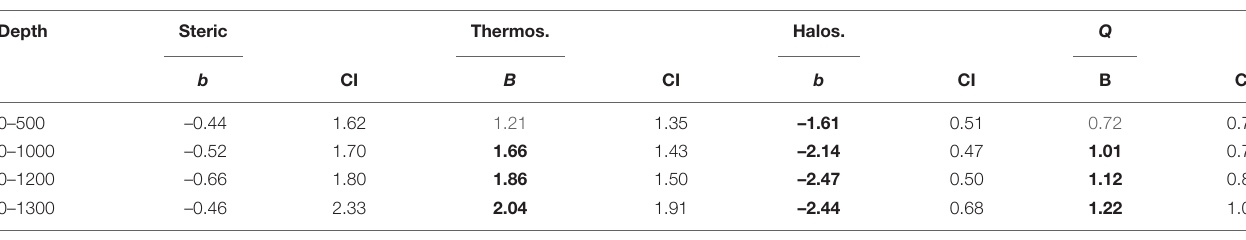
Steric Thermos. Halos.